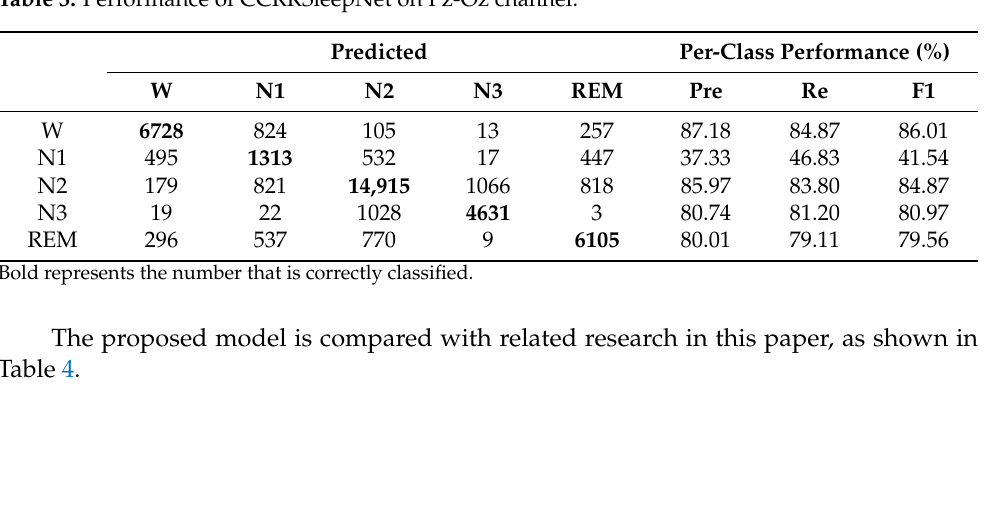
Table 3. Performance of CCRRSleepNet on Pz-Oz